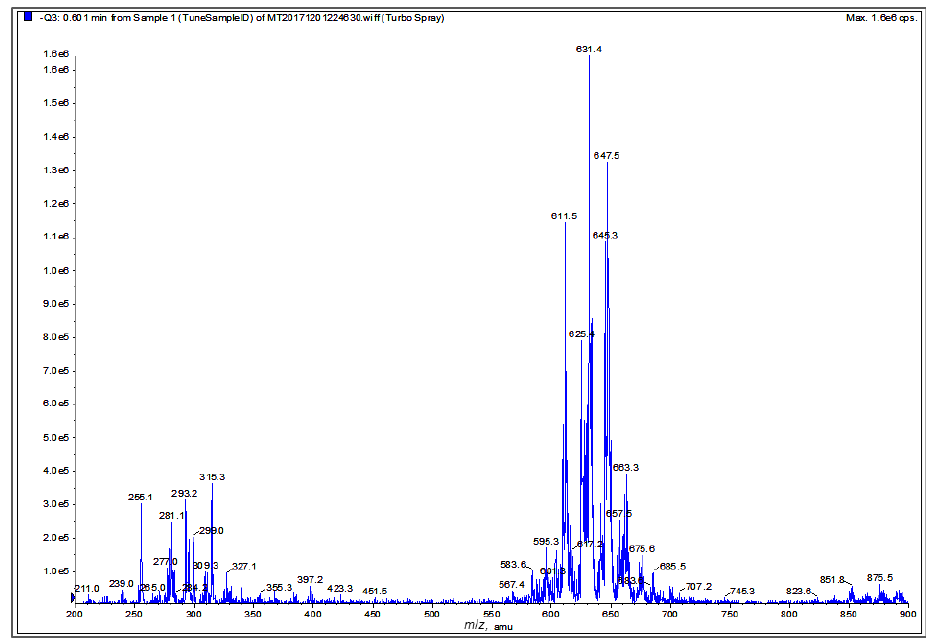
Figure 8. Chemical fingerprint of the graviola DCM extract. Electrospray ionization–mass spectrometry ( ESI-MS) analysis of graviola DCM extract in negative ion mode. The cluster at m / z 567.4–685.5 is suggestive of acetogenin ion peaks while the cluster at m / z 239–327 is suggestive of potential alkaloid and smaller acetogenin ion peaks.